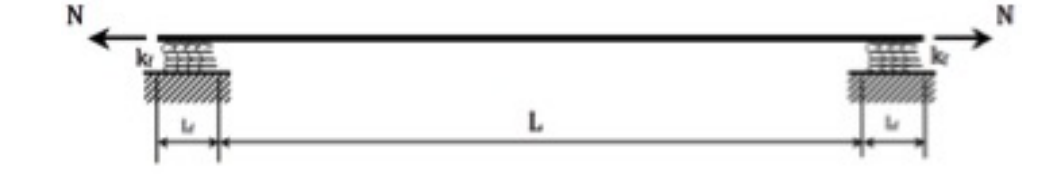
Figure 3. Sketch of the computational model.